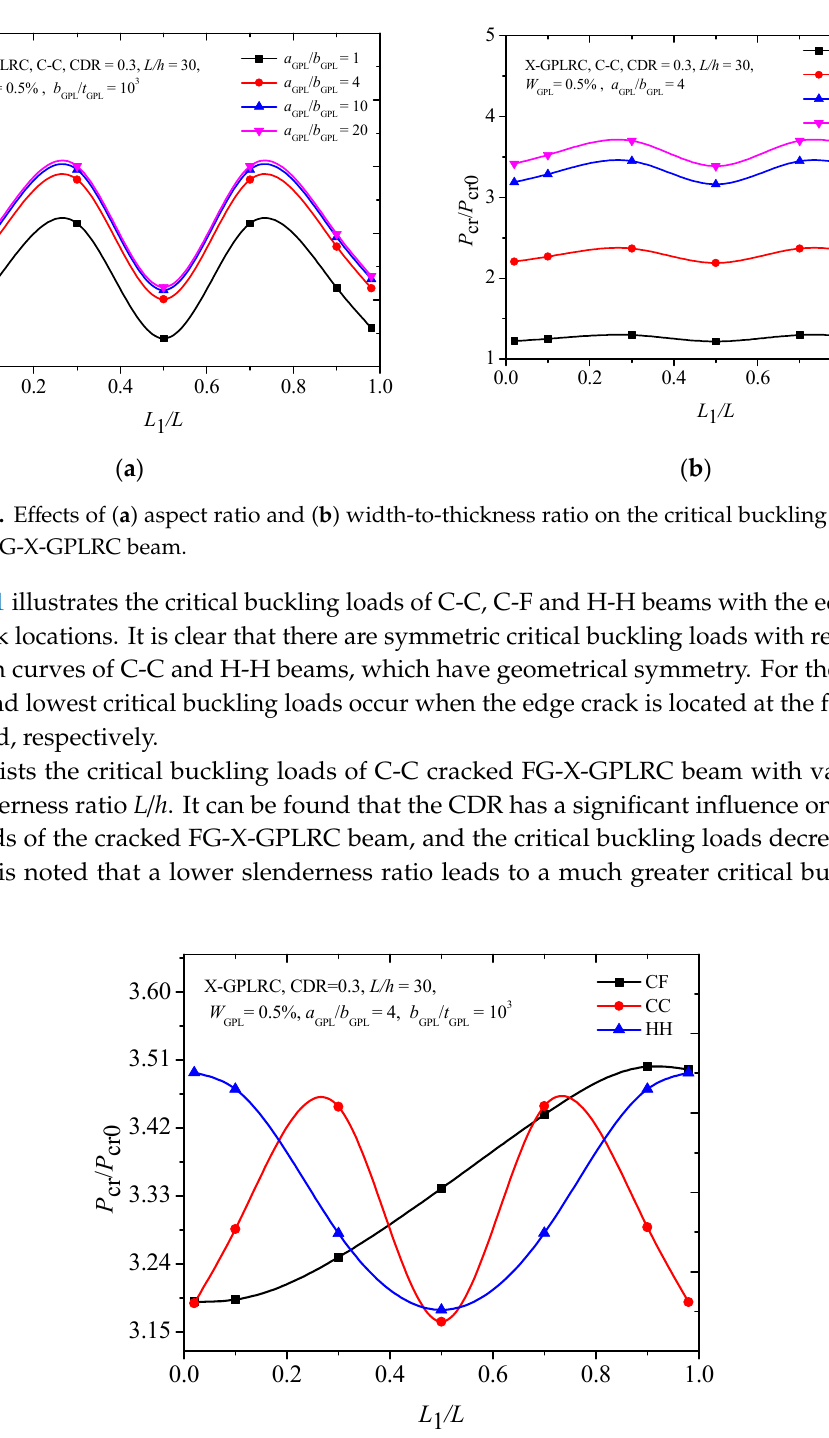
Figure 11. Critical buckling load of cracked FG-X-GPLRC beams with different boundary conditions.